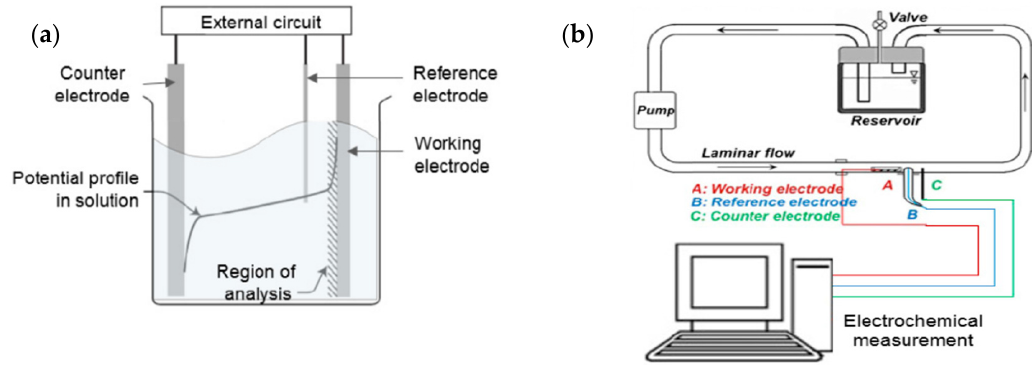
Figure 5. ( a ) An amperometric sensor circuit; ( b ) An experimental setup to monitor corrosion of biodegradable metal alloy [4].